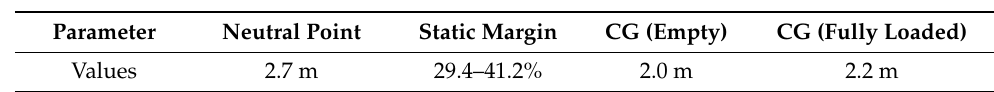
Figure 35. Coefficient of moment versus angle of attack. Table 20. Neutral point and static margin.